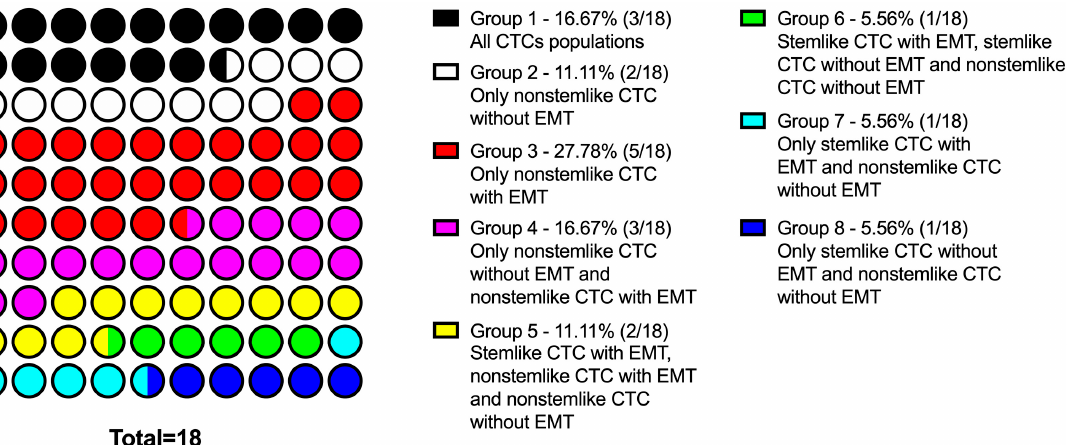
Figure 2. Contingency of personal CTCs profile in breast-cancer patients. Interpersonal heterogeneity characterized with various combinations of CTCs with and without stemlike and / or EMT features. Eight patient groups with a combination of various CTC phenotypes presented.